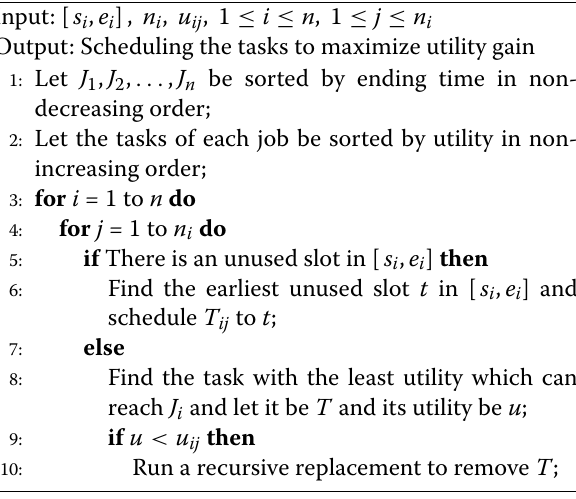
Algorithm 2 EDF-based Algorithm